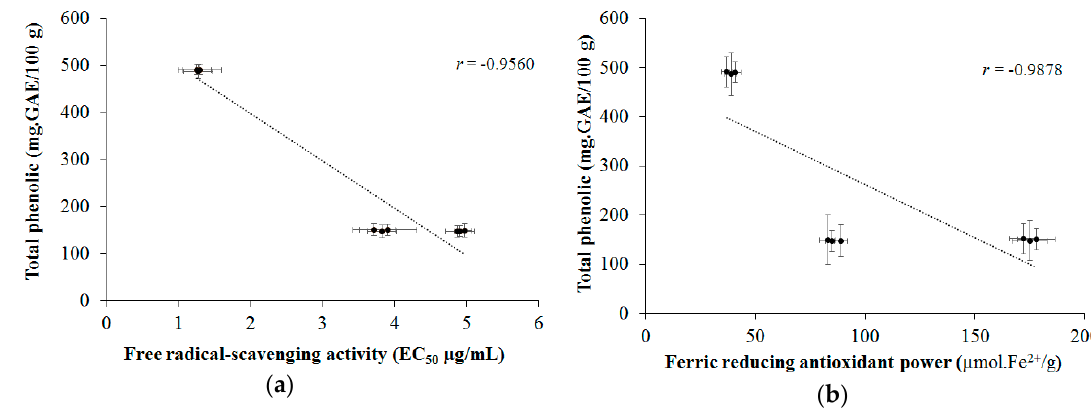
Figure 3. Correlation: between TPC and the DPPH radical scavenging assay ( a ); and between TPC and FRAP assay ( b ). The values of mean ± standard deviation (SD) correspond to averages from three